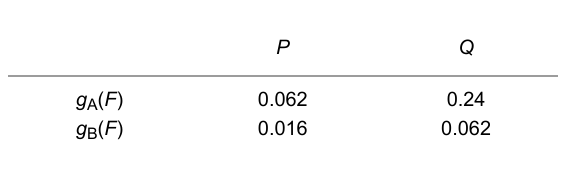
Table 1: Constants P and Q for approximation curves g A ( F ) and g B ( F